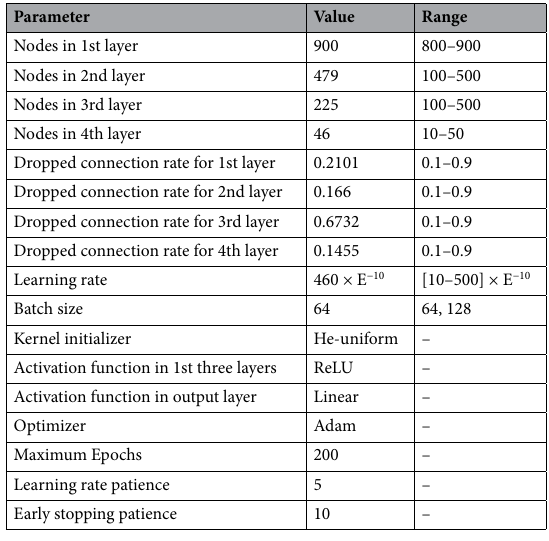
Table 1. Parameters of the final deep learning model, and parameter range.